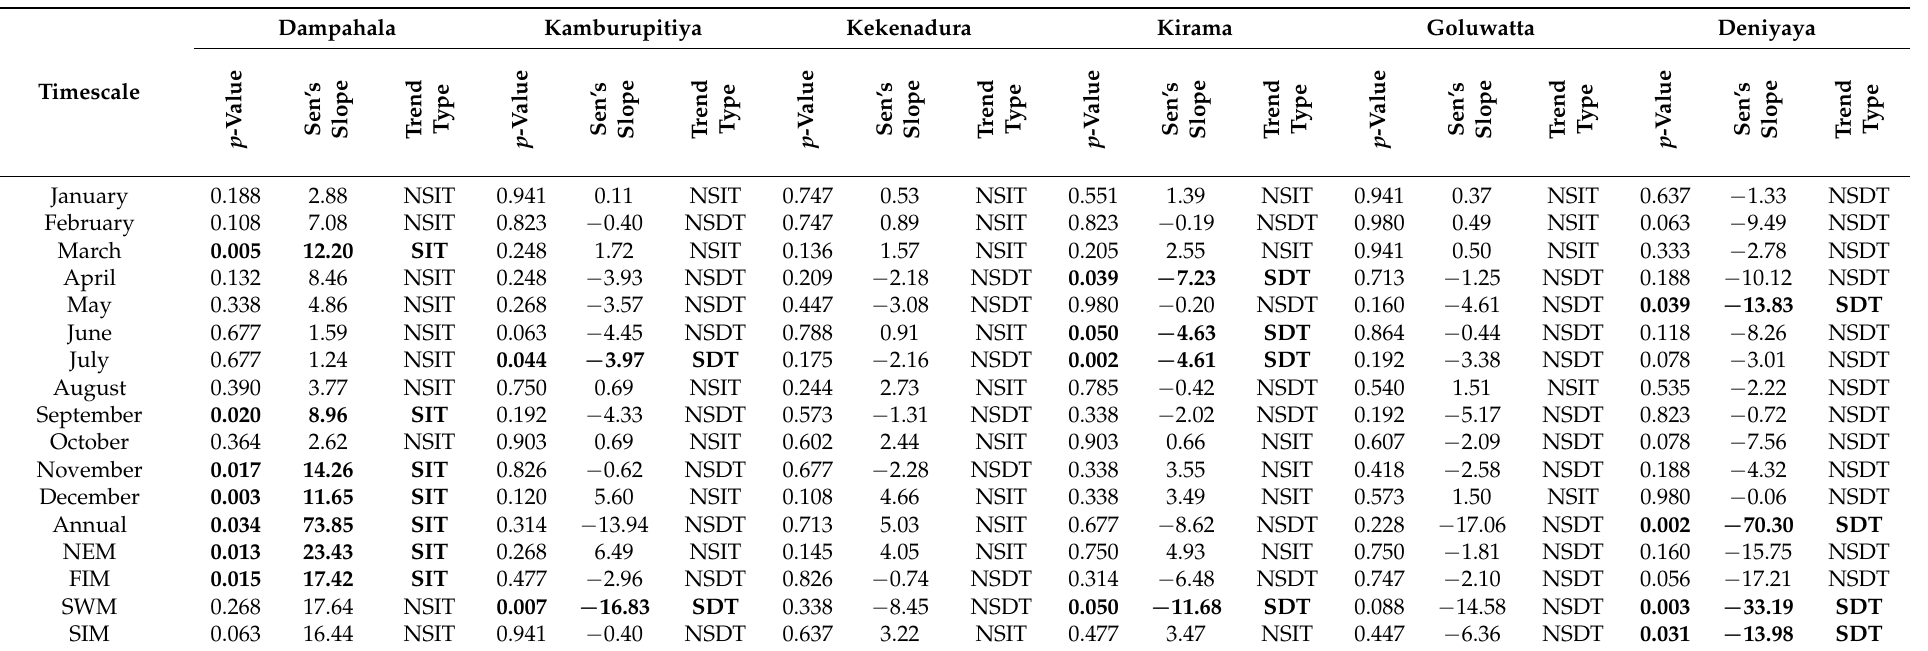
Table 3. Trend analysis results for the rainfall